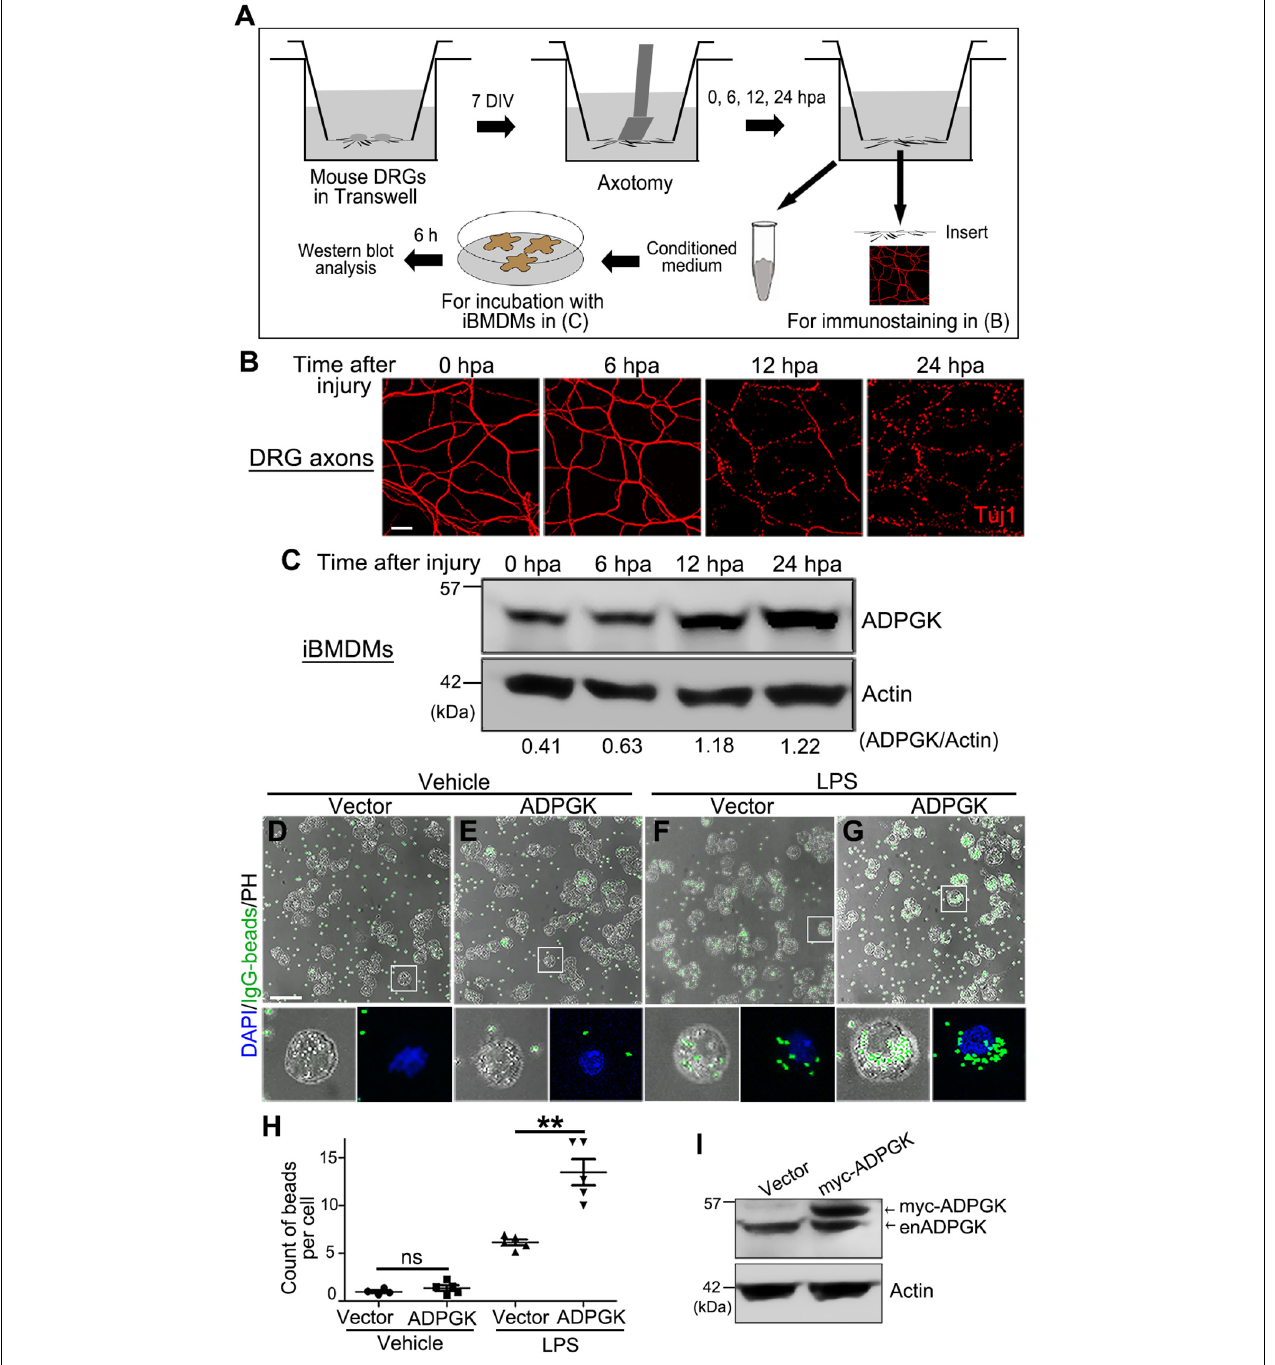
FIGURE 4 | Injured axons induce ADPGK upregulation in macrophages non-cell autonomously and OE of ADPGK promotes phagocytosis. (A) A schematic diagram of deriving conditioned medium using the Transwell dish and an in vitro injury model of mouse DRG axons and treating the iBMDMs with the axon-derived medium. DIV, days in vitro . hpa, hours post axotomy. (B) Representative confocal images of mouse DRG axons at indicated time points after axotomy. Axonal integrity is examined by immunostaining for Tuj1. (C) The representative western blot analysis of ADPGK protein levels in the iBMDMs that are incubated with the conditioned media derived at indicated time points after axotomy. Shown is a representative image of three independent repeats. (D–G) The representative images of iBMDMs transfected with the empty vector (Vector) or myc-ADPGK (ADPGK) engulfing IgG-coated latex beads (green). The cells are treated with PBS (Vehicle) or LPS for 24 h. PH, phase contrast. (H) The average counts of beads per cell in (D–G) are quantified. (I) Western blot analysis confirming the lentiviral expression of myc-ADPGK in iBMDMs in (D–G) . enADPGK, endogenous ADPGK. Means ± SEM; n = ∼ 100 cells from pooled results of 5 repeats per group. Student’s t -test; ** p < 0.01; ns, not significant. Scale bars: 25 µ m in (B) and 50 µ m in (D–G)